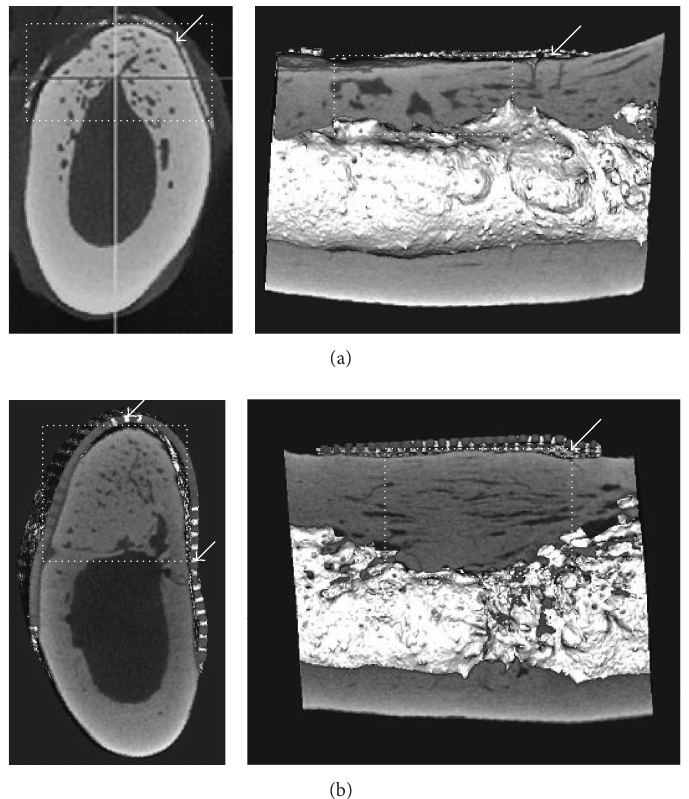
Figure 3: Alveolar bone regeneration using poly(L-lactide-co- 𝜀 -caprolactone)/ 𝛽 -TCP membrane and bFGF-gelatin sponge in the mandible of a canine [32]. Micro-CT images of frontal and sagittal sections in the mandible 6 months postoperatively. (a) Group using only GBR membrane, and (b) group using membrane and bFGF-gelatin sponge circles: regenerated bone; and arrow: GBR